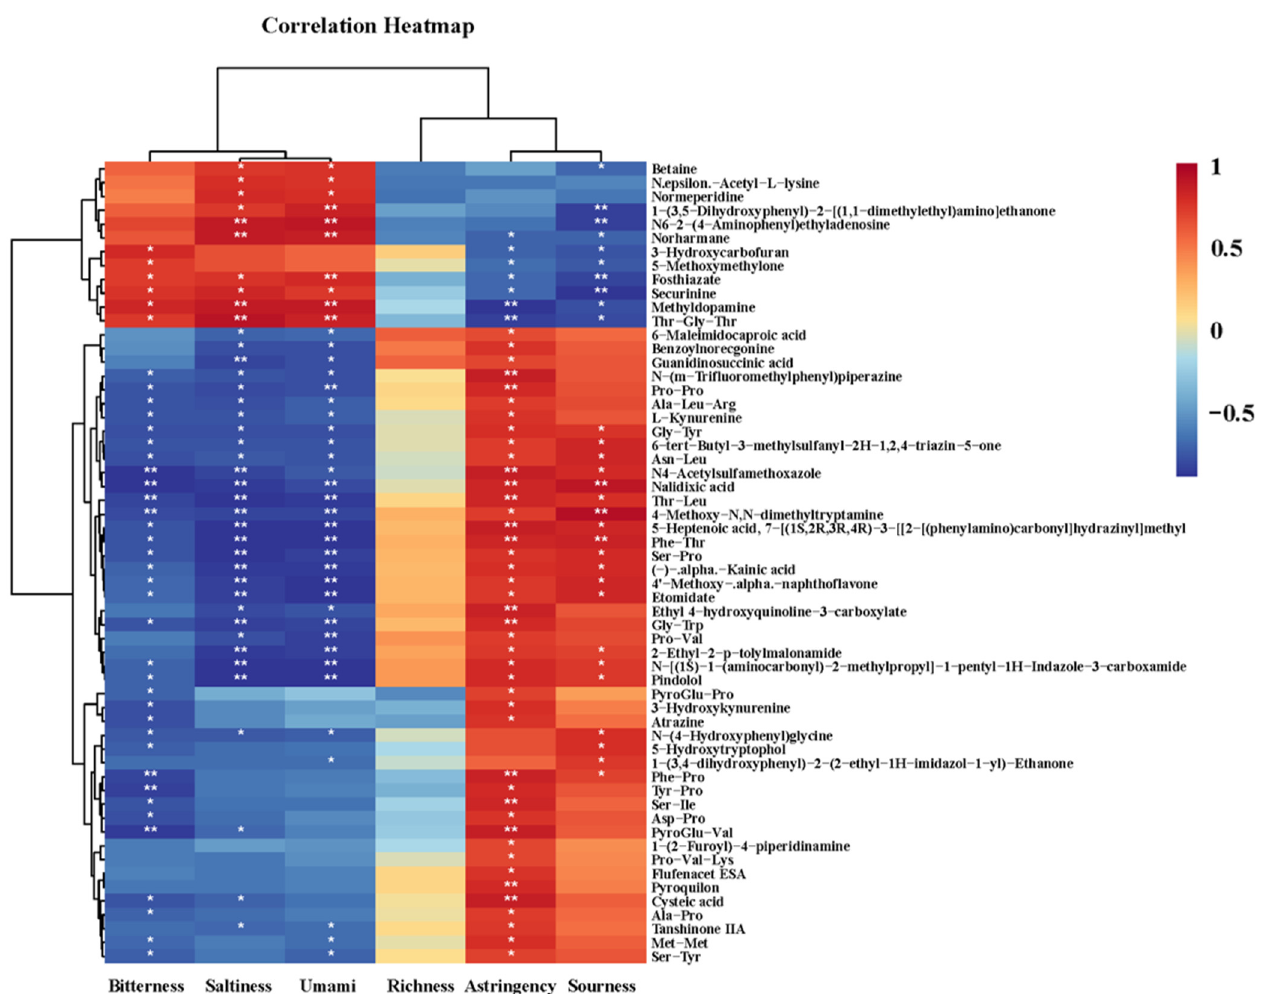
Figure 7. A correlation heatmap of electronic tongue results and non-volatile compounds of mussel MRPs with different polar lipids. Note: *: p < 0.05; **: p < 0.01. MRPs with different polar lipids. Note: *: p < 0.05; **: p <